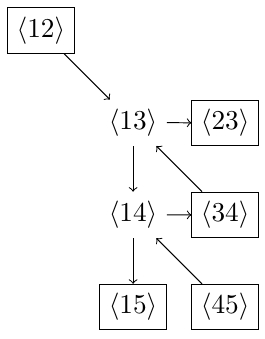
Figure 3 . Quiver of the initial seed of the cluster algebra of Gr(2 ;